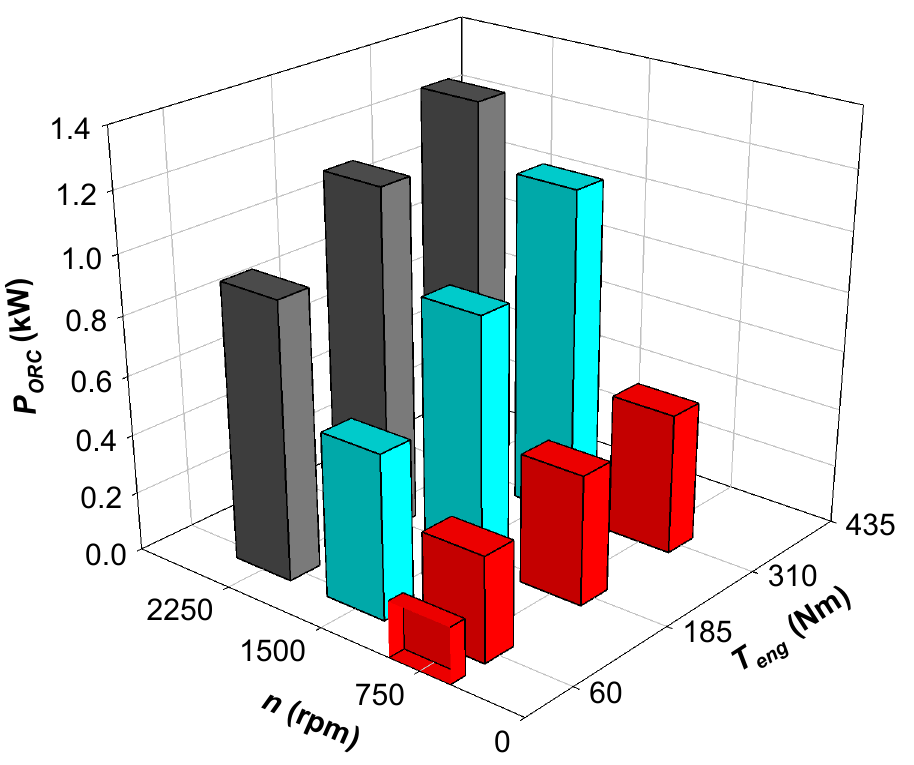
Figure 12. ORC delivered power at the engine operating points of the discretization grid.